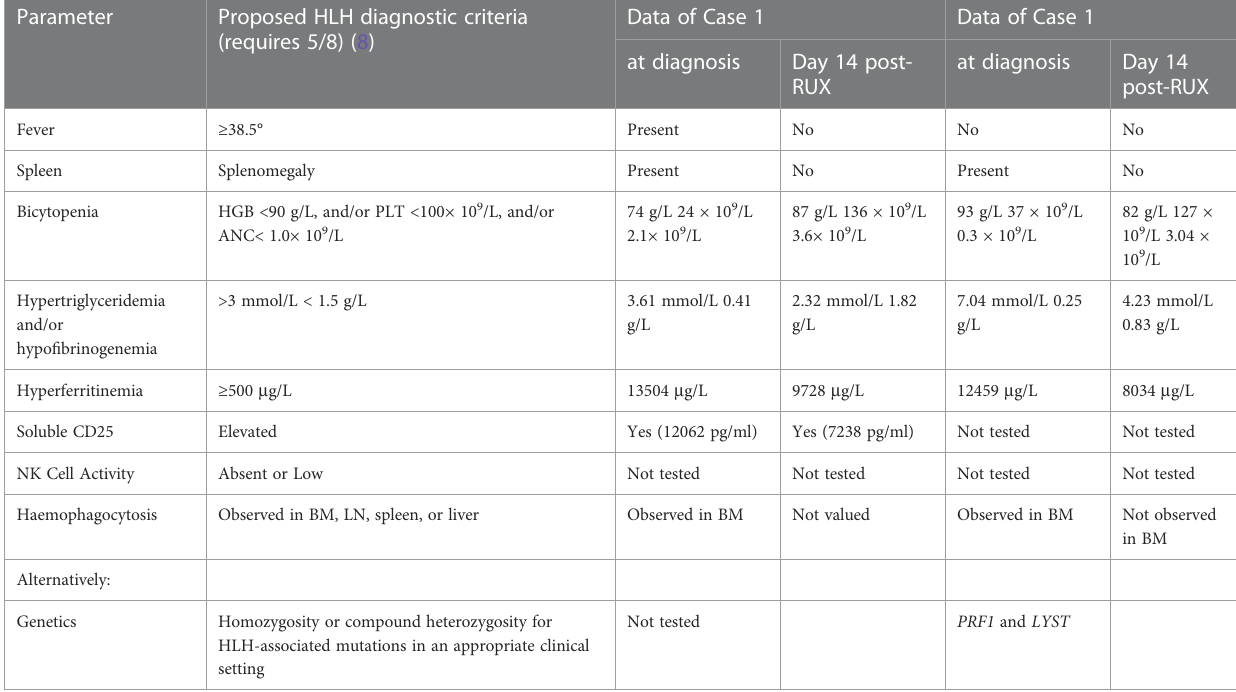
TABLE 1 Clinical and laboratory parameters measured in both patients at diagnosis and Day 14 post-ruxolitinib